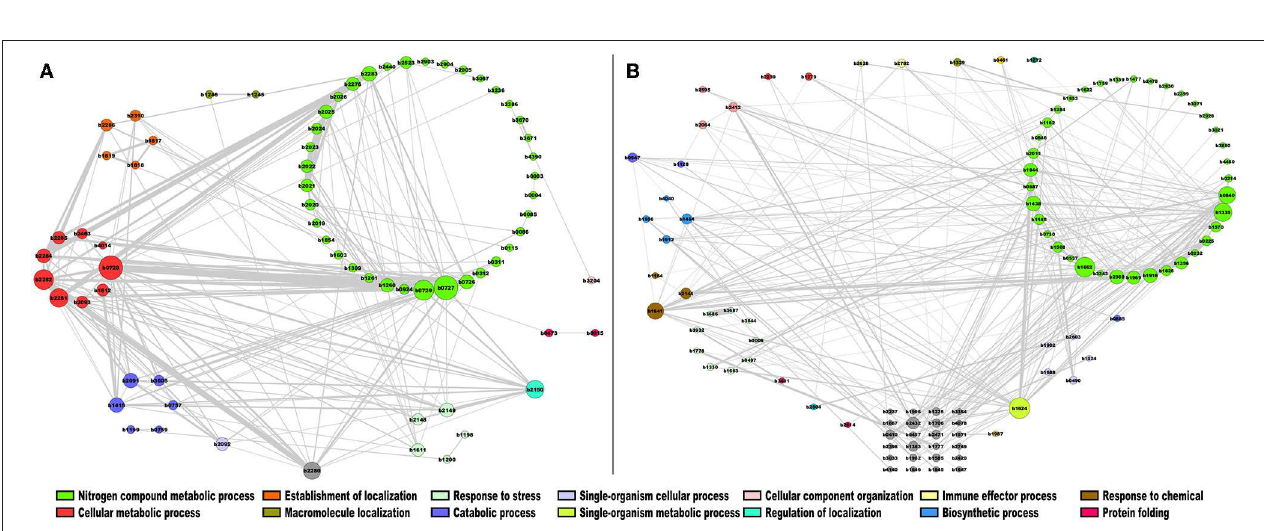
FIGURE 6 | Co-expression network of S. flexneri. The most highly correlated genes were plotted in Cytoscape (Smoot et al., 2010). The size of the modules corresponds to their degree of connectivity, while the widths of the edges represent the weights of the correlations, gray nodes do not have an assigned function. (A) TFs; (B) metabolism modules.